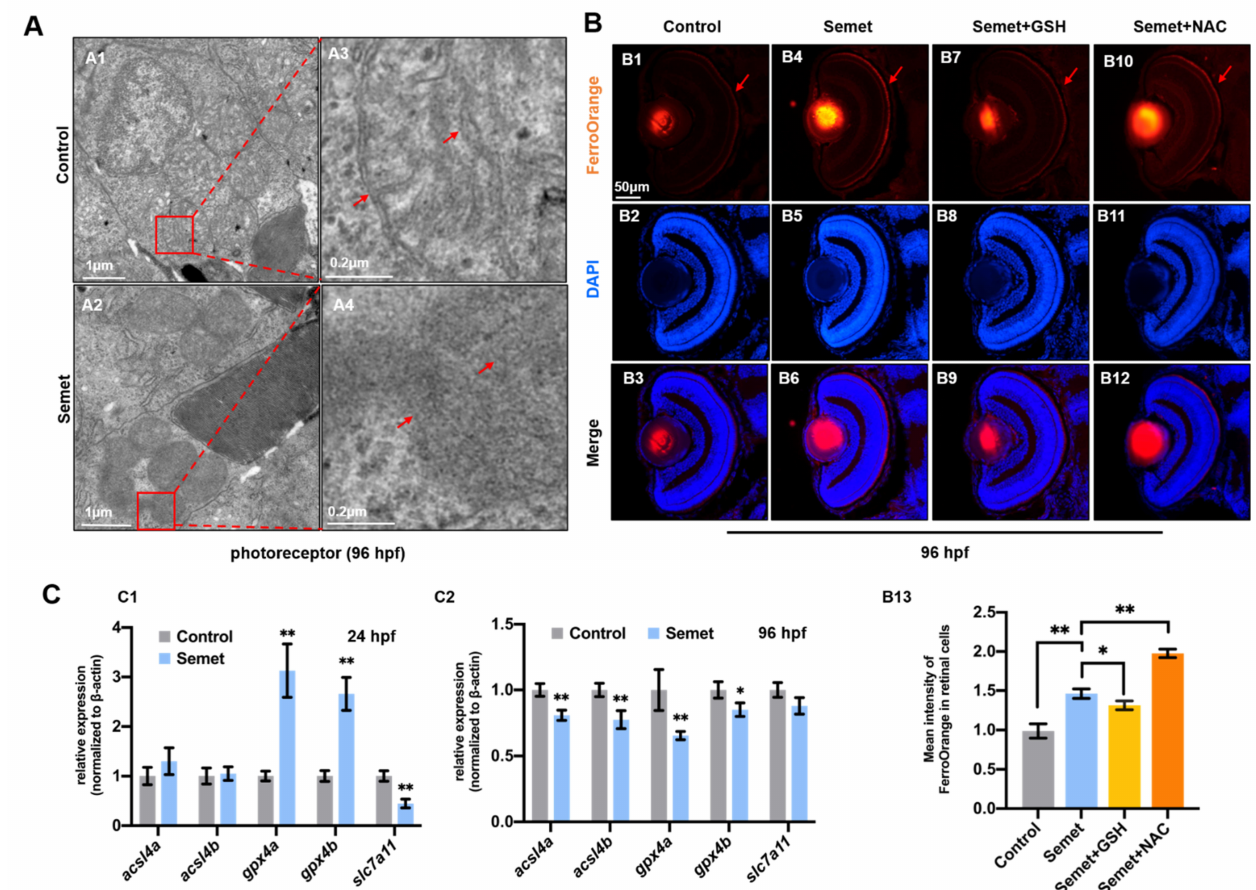
Figure 4. Ferroptosis in selenium-treated embryos. ( A ) TEM analysis of retinal cells in control and selenium-stressed embryos at 96 hpf (red squares and arrows indicate mitochondria). ( A3 , A4 ) are magnified domains of red boxes marked in ( A1 , A2 ), respectively. ( B ) Iron distribution assay by FerroOrange probe in control, semet, semet plus GSH and semet plus NAC groups at 96 hpf ( B1 – B12 ). Measurement of FerroOrange staining in retinal cells ( B13 ). ( C ) Expressions of ferroptosis marker genes in control and selenium-treated embryos at 24 hpf ( C1 ) and 96 hpf ( C2 ). **, P < 0.01; *, P <